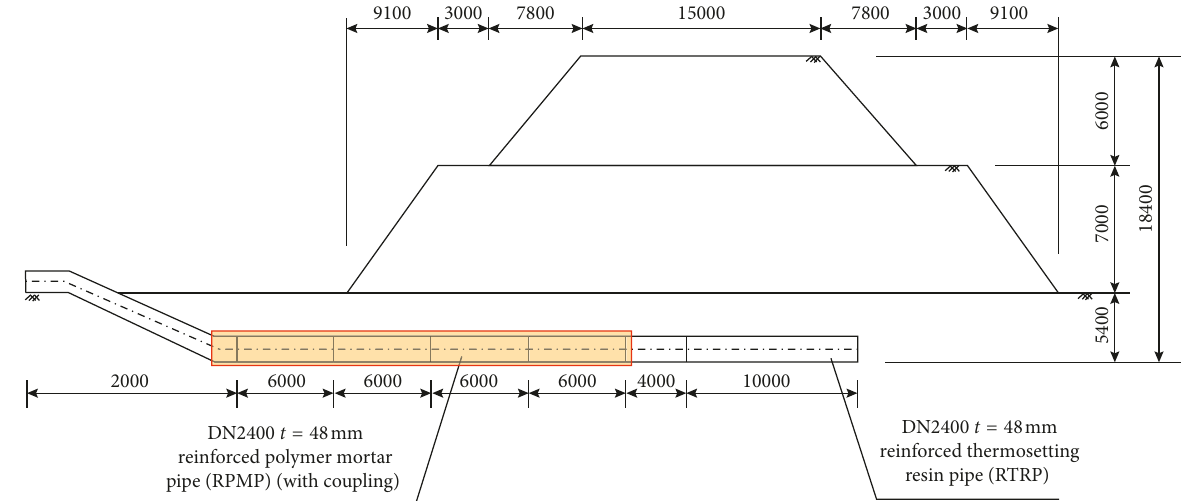
Figure 2: Side elevation of underground GFRP pipe.